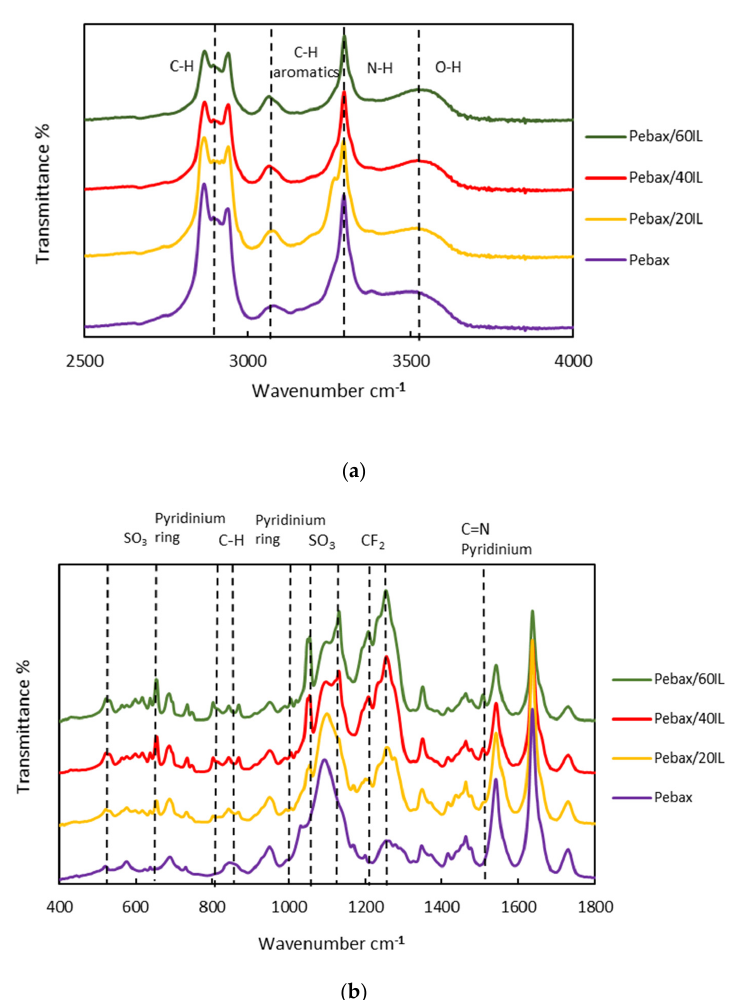
Figure 3. Comparison between the Pebax ® 1657 and the composite ionic liquid and polymer membranes (CILPMs) (Pebax/20IL, Pebax/40IL; Pebax/60IL—full names in Table 1) studied in this work in the range of: ( a ) 2500–4000 cm − 1 ; ( b ) 1800–400 cm − 1 . [C 2 C 1 py] [C 4 F 9 SO 3 ] characteristic peaks are identified.